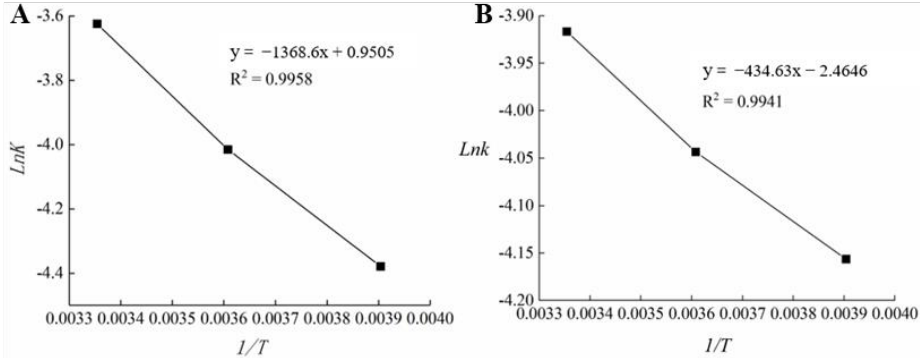
Figure 8. Regression analysis of the relationship between temperature and reaction rate of commercial films ( A ) and fish skin gelatin/L-arabinose (FG-Ara) composite films ( B ).